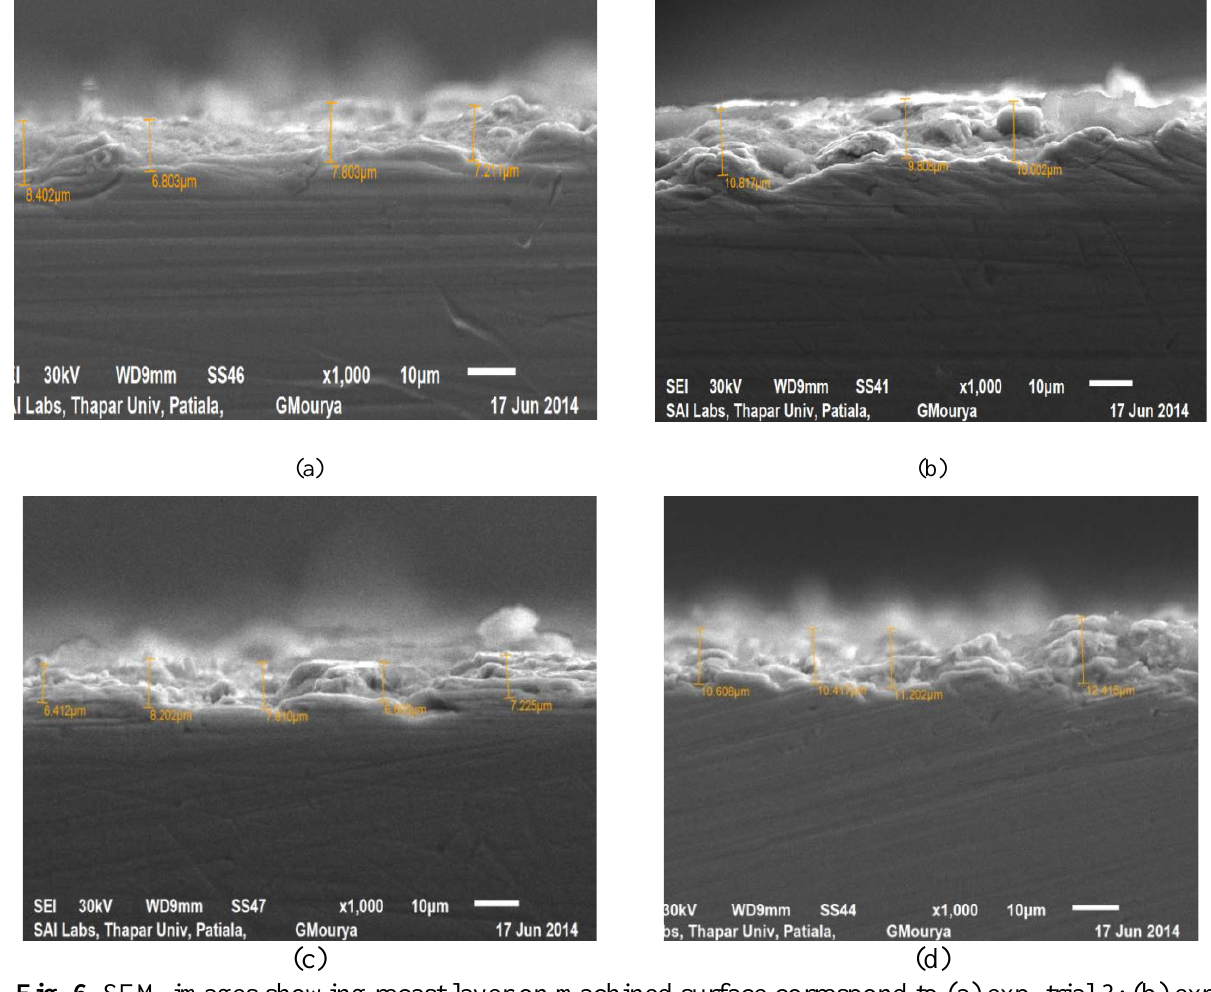
Fig. 6. SEM images showing recast layer on machined surface correspond to (a) exp. trial 3; (b) exp. trial 4; (c) exp. trial 15; (d) exp. trial